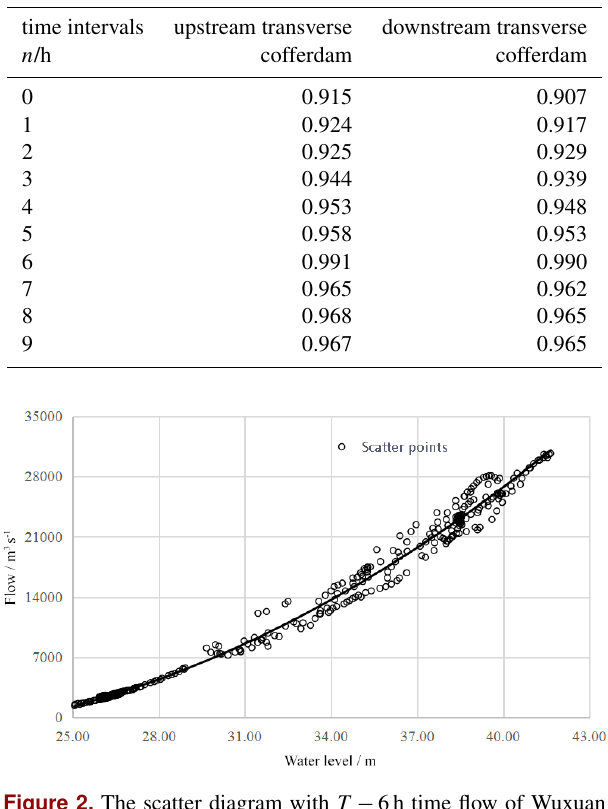
Table 1. Correlation coefficient of the fitting synthetic curves at different time intervals n .